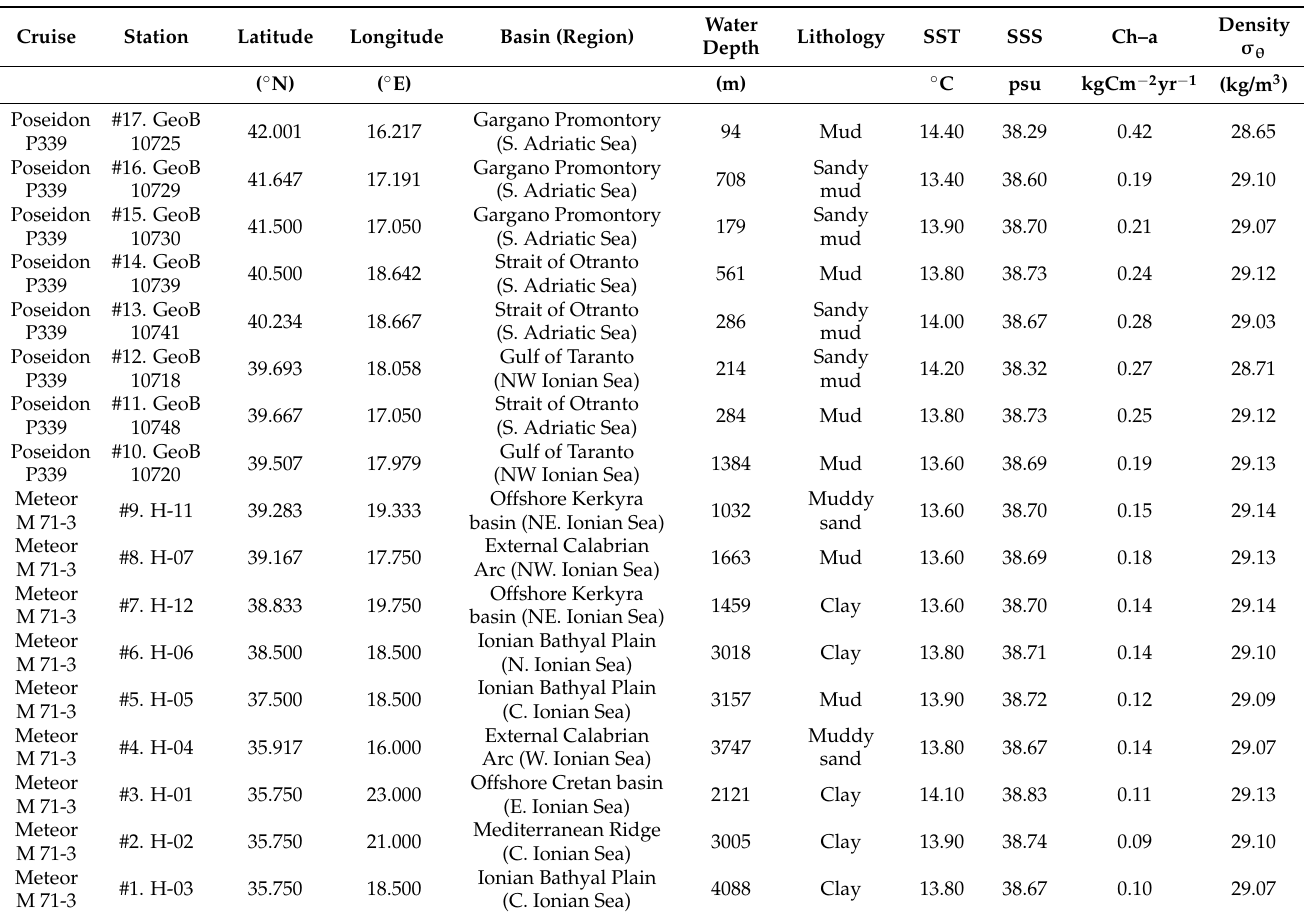
Table 1. Core-top locations, coordinates, scientific expeditions, seafloor water depths, lithology, and mean annual SST, SSS and density data along with Chl-a